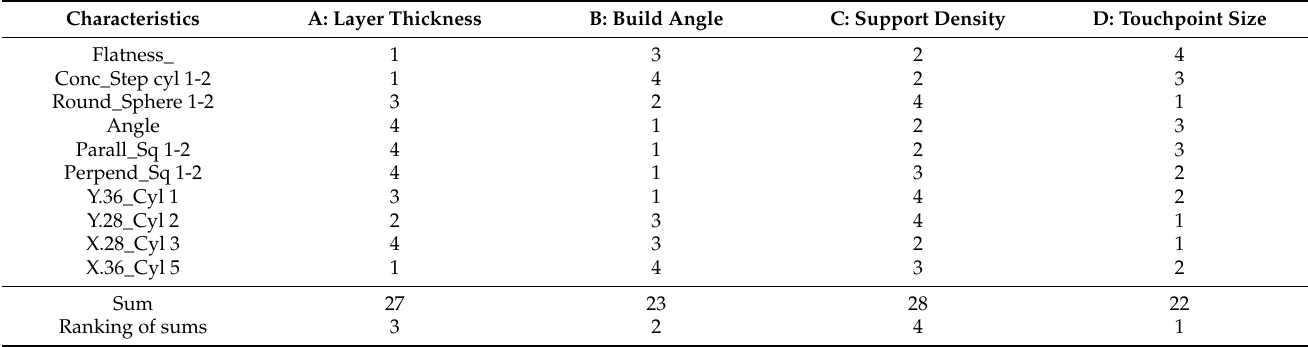
Table A4. Mean ranking of parameters for geometric characteristic of cast